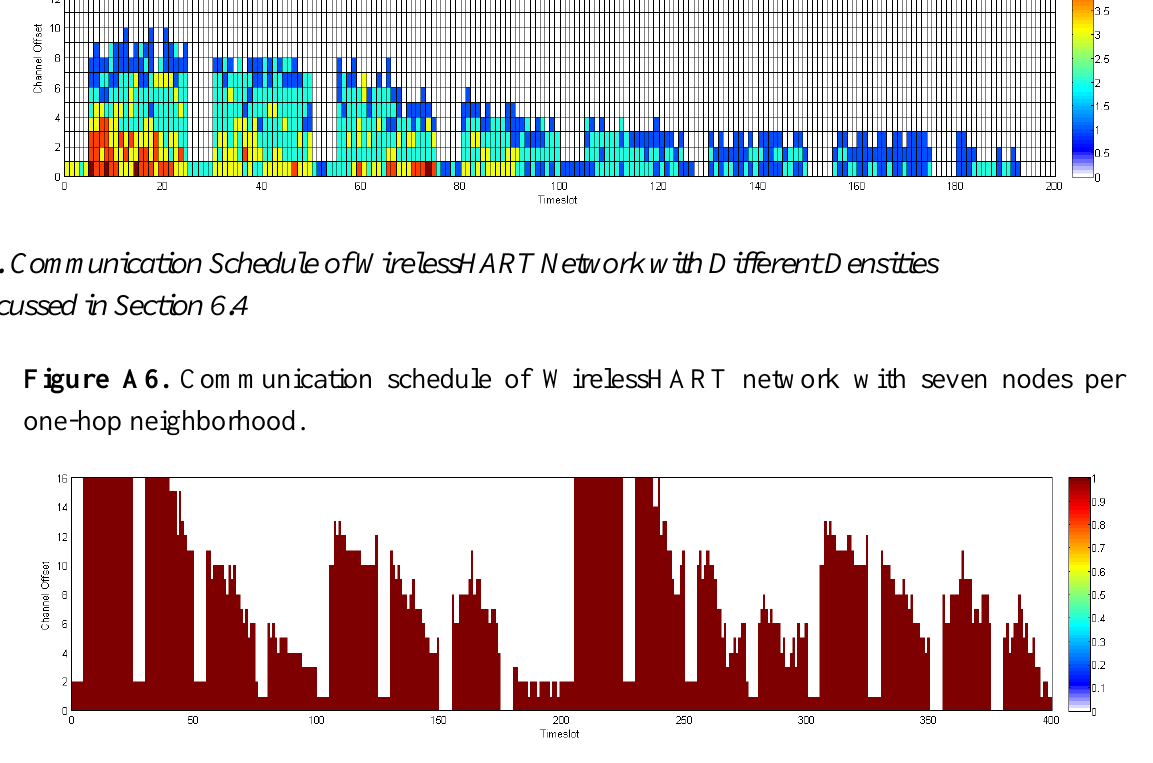
Figure A7. Communication schedule of WirelessHART network with nine nodes per one-hop